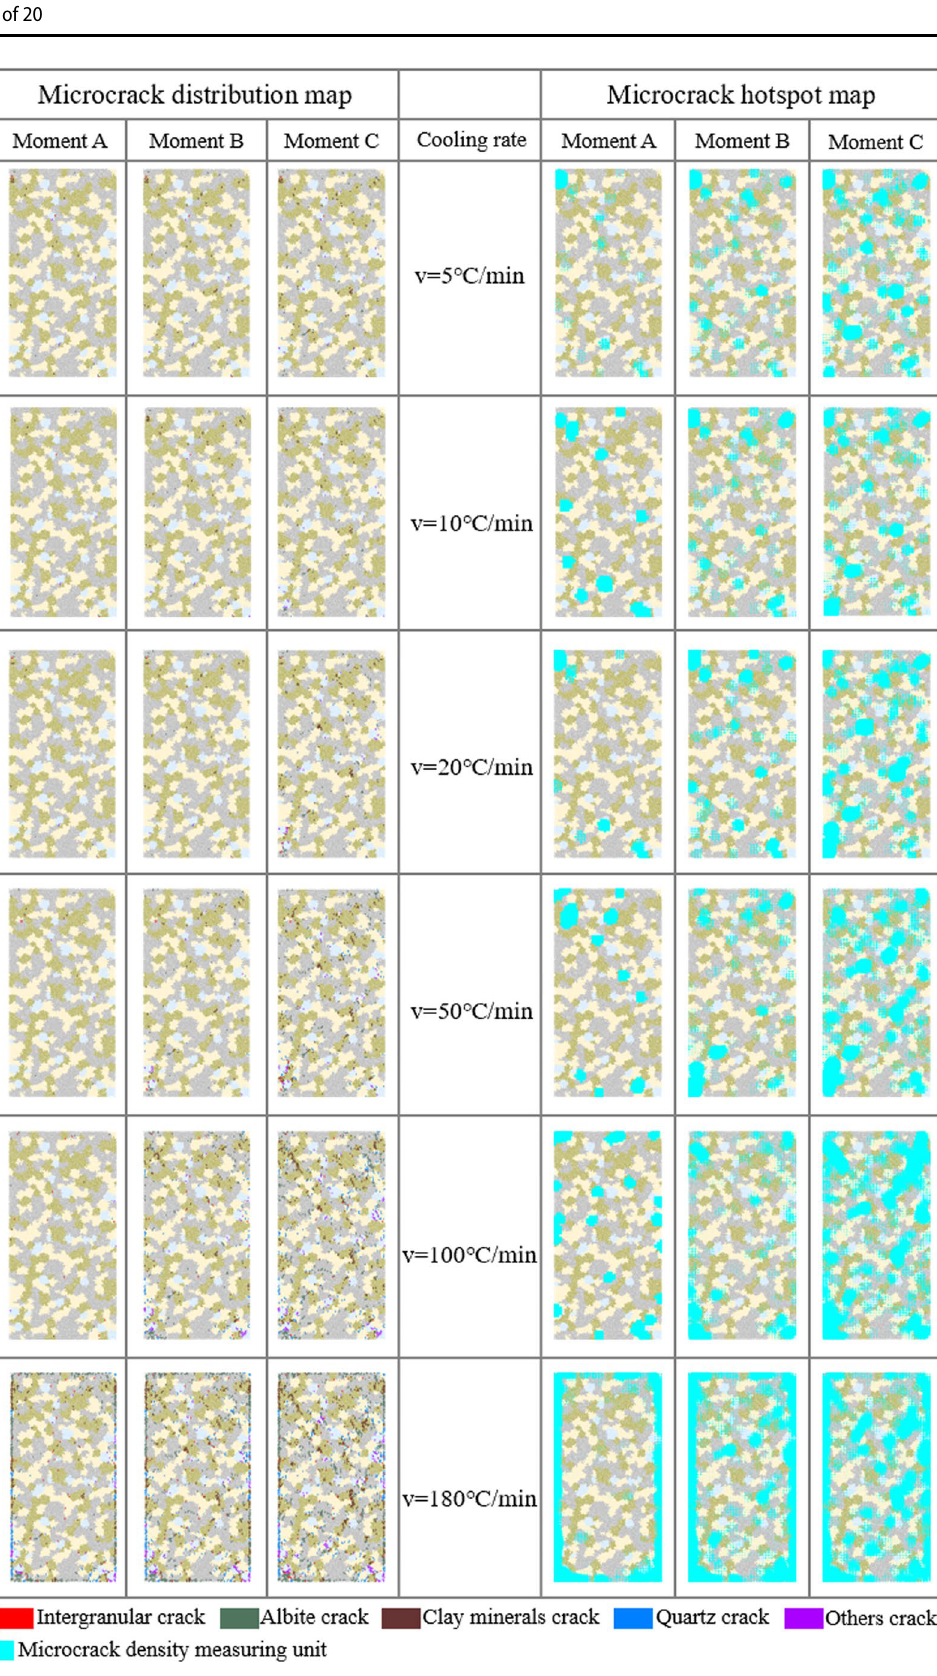
Fig. 12 Microcrack distribution and crack density distribution of